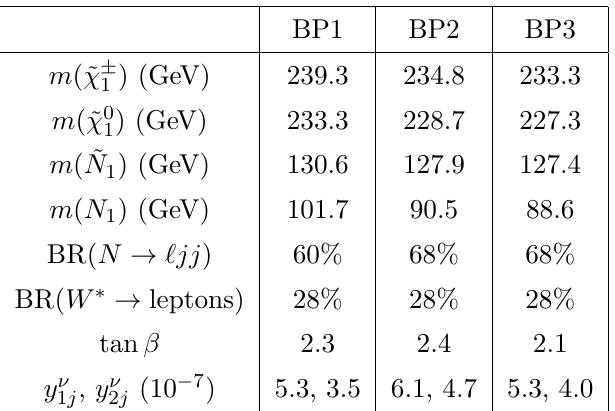
Table 1 . Mass spectra and the most important parameters of our BPs. The neutrino Yukawa couplings are given for the flavour of the lightest right-handed sneutrino. The amplitude of our signal process will be proportional to these Yukawa couplings.